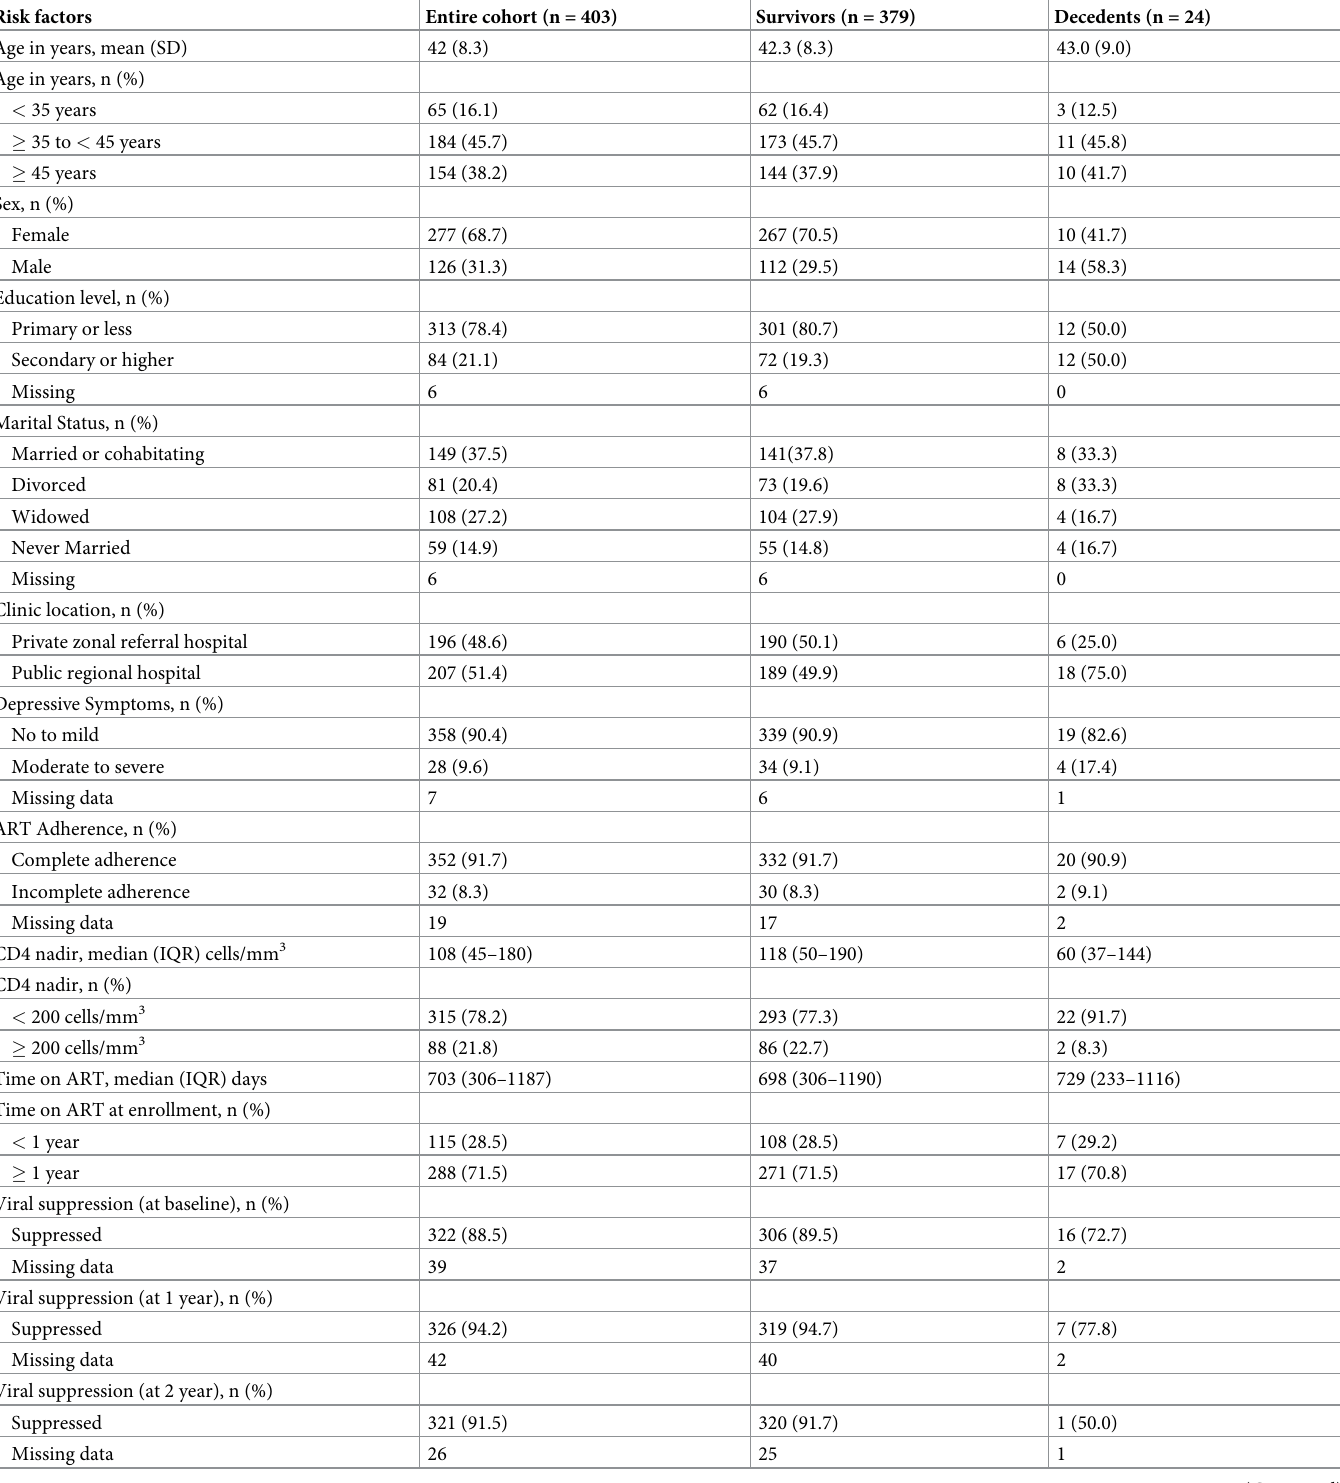
Table 1. Distribution of demographic characteristics, clinical and laboratory findings by mortality status among a cohort of HIV-infected patients on antiretroviral therapy in northern Tanzania,